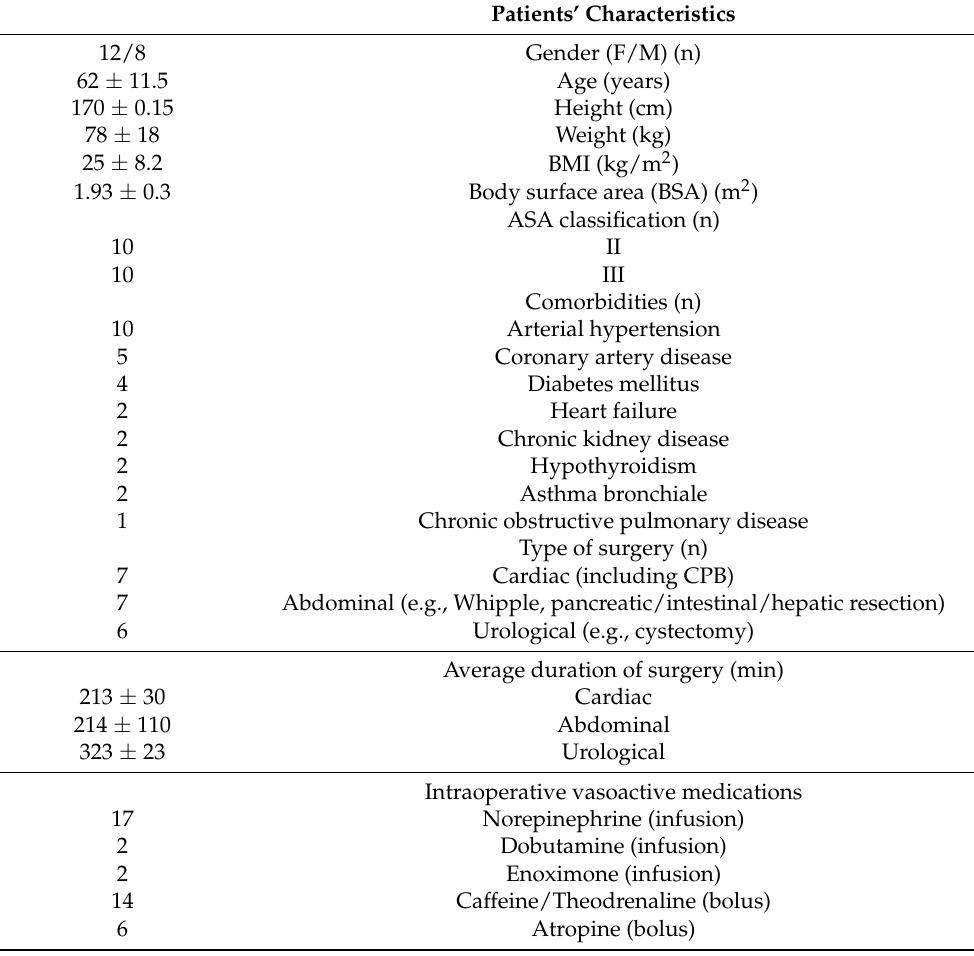
Table 1. Patient demographics, biometrics, comorbidities, type of surgery, length of surgery, and inoperative vasoactive medications. Values are reported as numbers or mean ± standard deviation (SD).